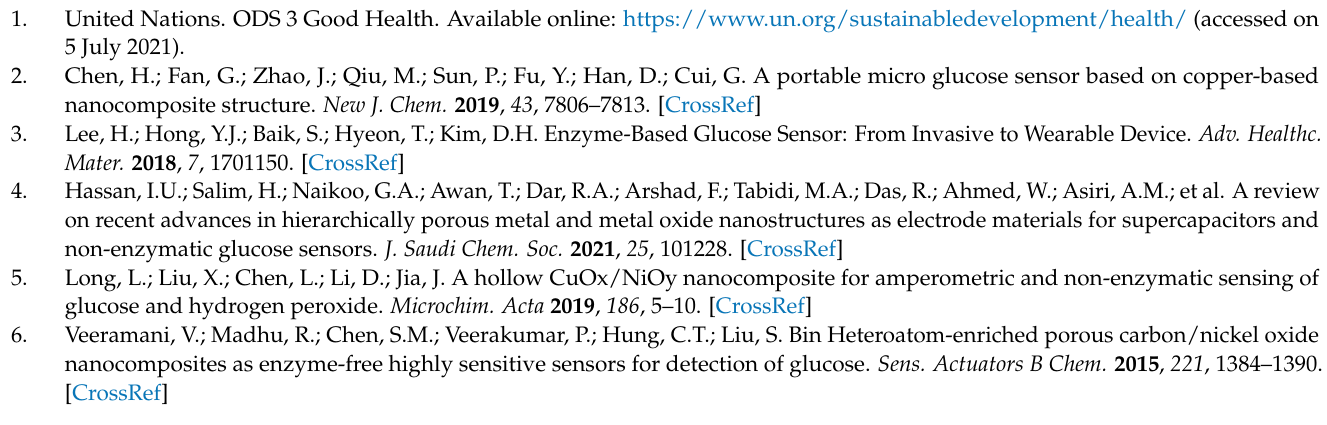
(b) 2000 × , Figure S2: Active area calculation for copper based electrode (a) Cyclic voltam-metry with 5 mM Cl 3 [Ru(NH 3 ) 6 ] in 0.1 M KCl with a scan rate from 500 to 10 mV s − 1 . (b) Randles-Equation linear regression. Figure S3: Active area calculation for copper oxide based electrode (a) Cyclic voltammetry with 5 mM Cl 3 [Ru(NH 3 ) 6 ] in 0.1 M KCl with a scan rate from 500 to 10 mV s − 1 . (b) Randles-Equation linear regression. Figure S4: Copper oxide electrode cyclic voltammetry curves (1 cycle, − 0.7 to +0.7 V vs. Ag/AgCl) with different glucose concentrations in 0.1 M